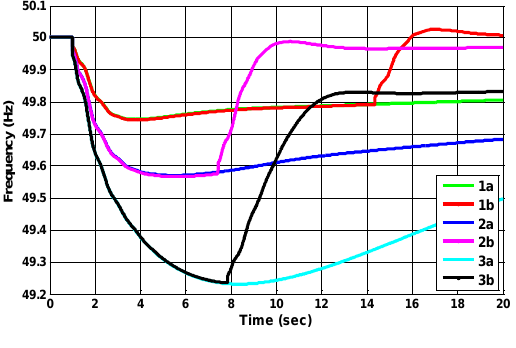
Figure 3 . Frequency profile with and without ES at